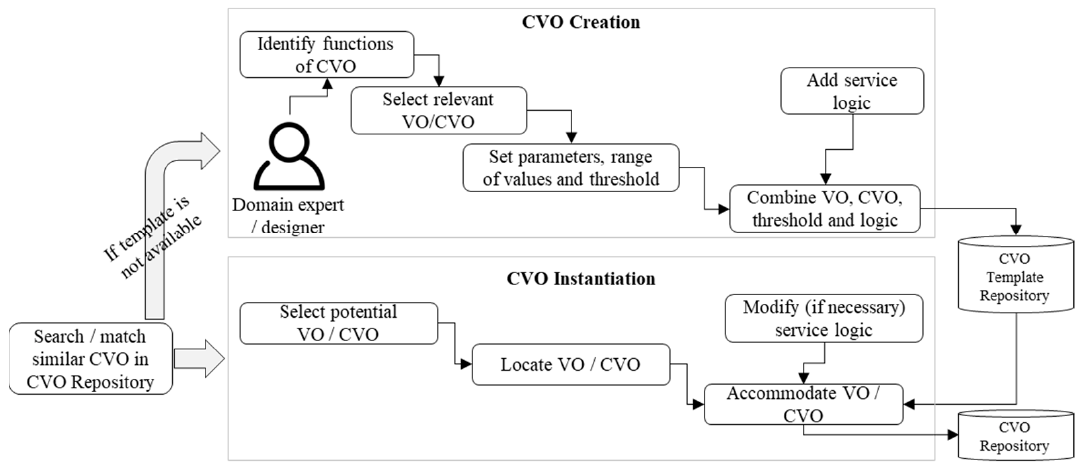
Figure 5. CVO creation and instantiation process at the CVO level.